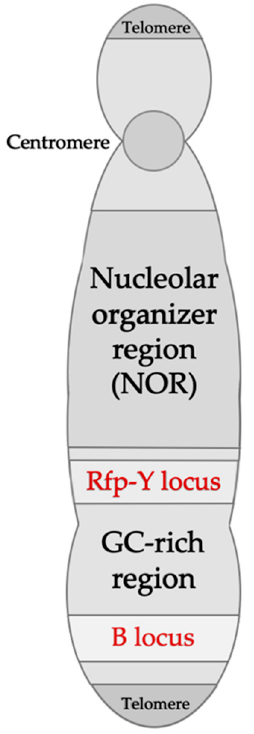
Figure 2. Schematic representation of the chicken microchromosome 16, indicating the MHC B and Rfp-Y loci. The B locus contains the B-F/B-L and the B-G regions corresponding to MHC class I, II, III, and IV (B-G) genes. The Rfp-Y locus contains nonclassical MHC class I and II genes. Adapted from Delany et al. (2009) [61] and Kaufman (2013) [19].